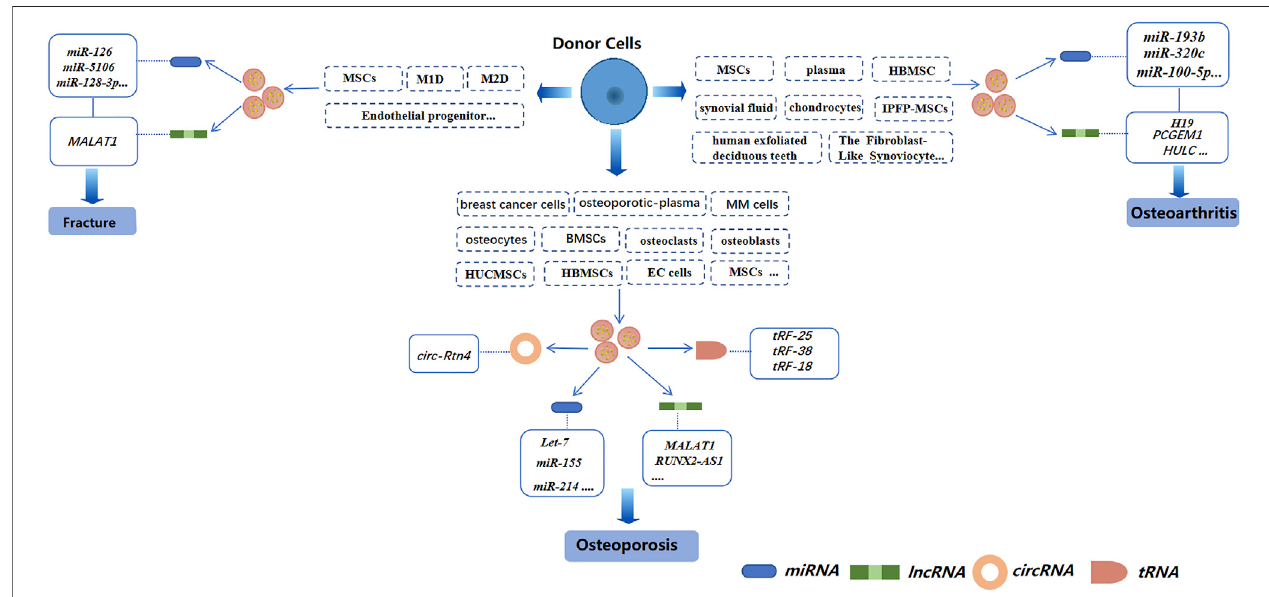
FIGURE 3 | Exosomal non-coding RNAs derived from different cells in three bone-related diseases (schematic). Different sources of exosomes, such as BMSCs, serum, and cancer-cell sources, have different effects on osteoporosis, osteoarthritis, and bone fractures by regulating different exosomal non-coding RNAs.